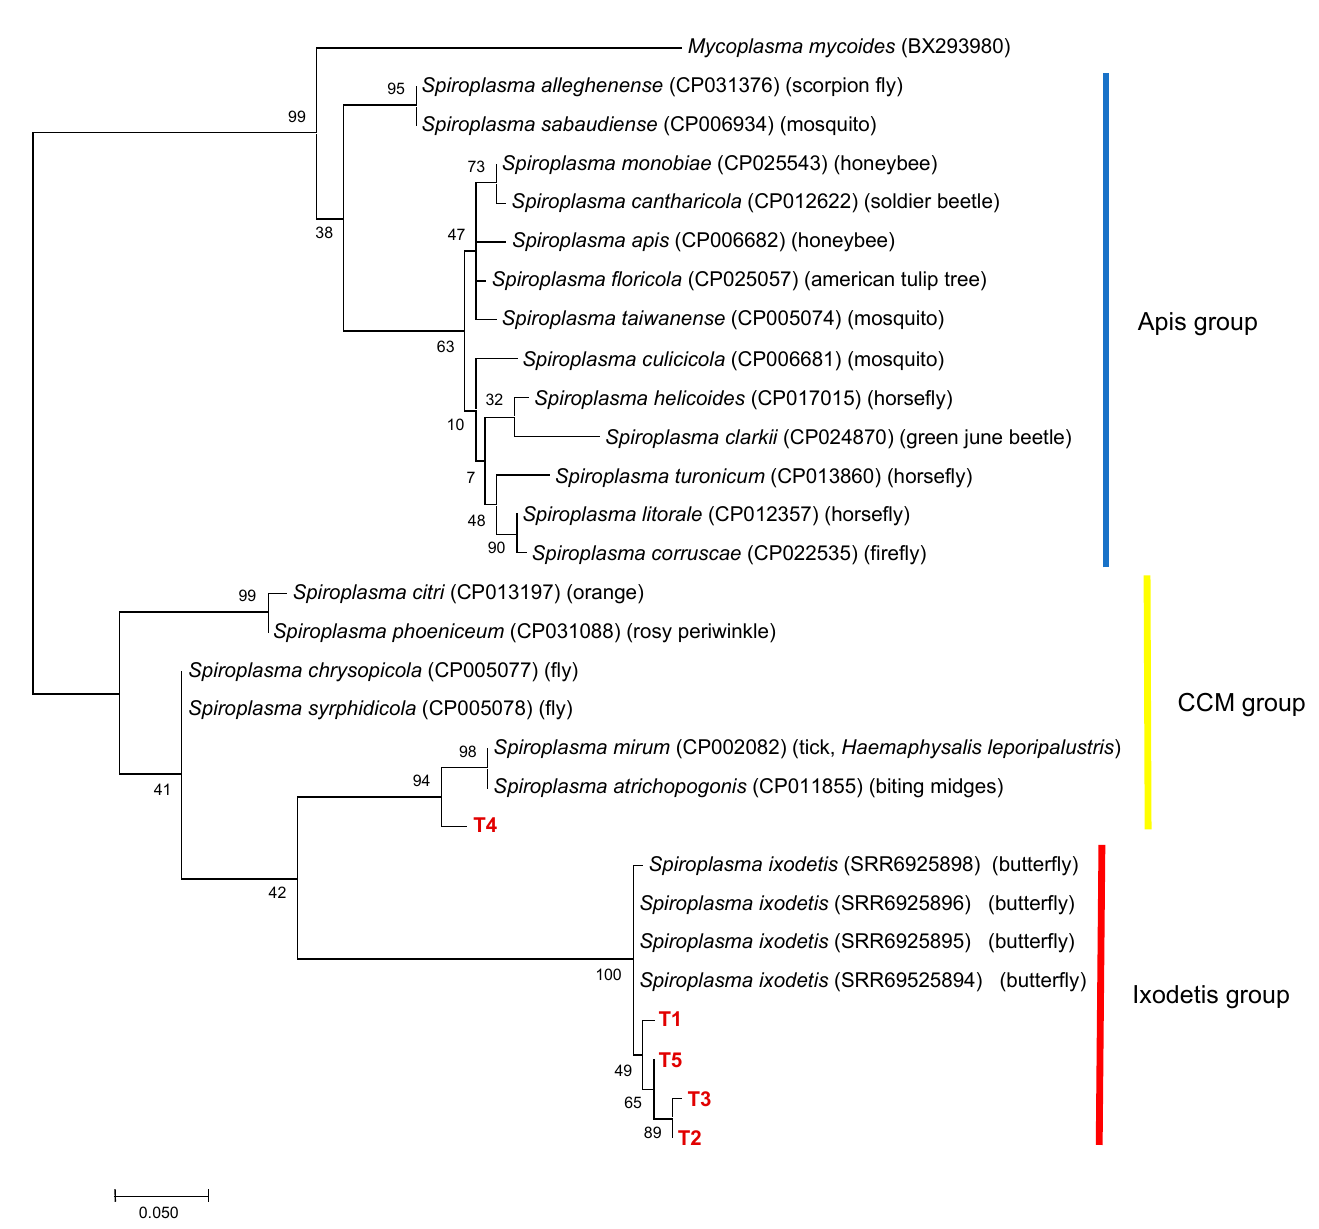
Figure 4. A phylogenetic tree based on the sequences of ITS region. The analysis was performed using a maximum-likelihood method based on the Tamura 3-parameter model. A discrete Gamma distribution was used to model evolutionary rate differences among sites (five categories (+G, parameter = 0.2599)) with bootstrap tests of 1000 replicates in MEGA7. The sequences obtained in this study are included with allele names provided in Table 3 and are shown in red. The sequences of other Spiroplasma species were retrieved from GenBank.